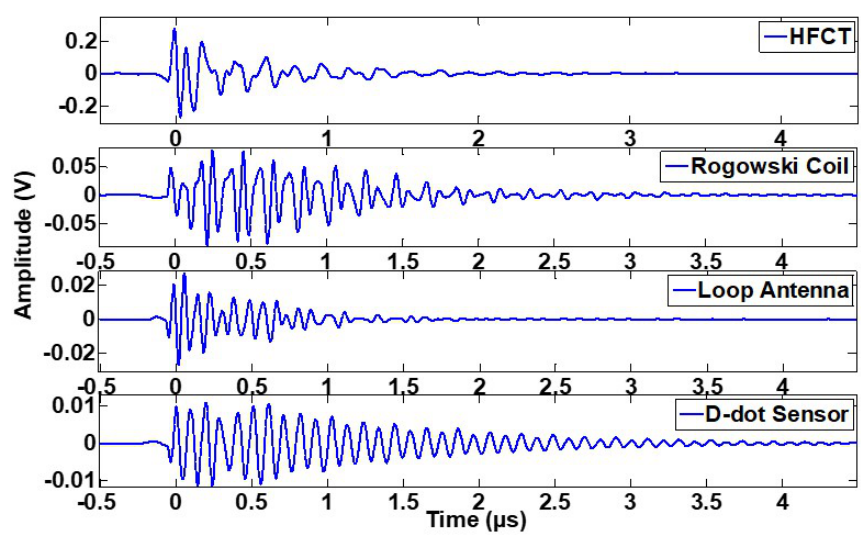
Figure 14. Internal PD within an insulator.